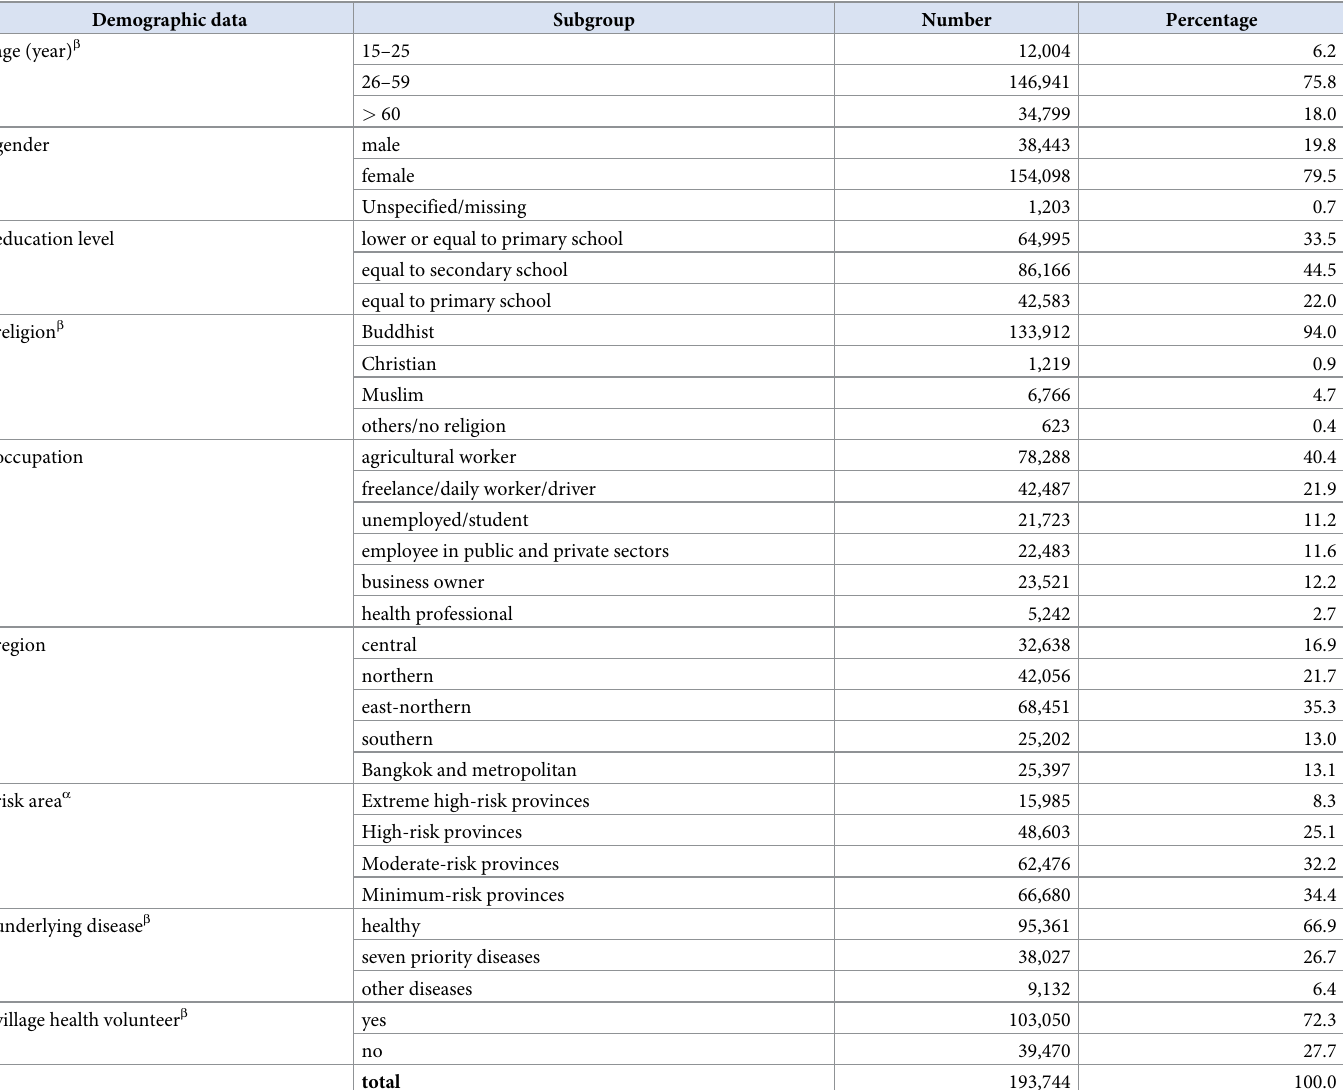
Table 1. The characteristics of respondents combined in six rounds of